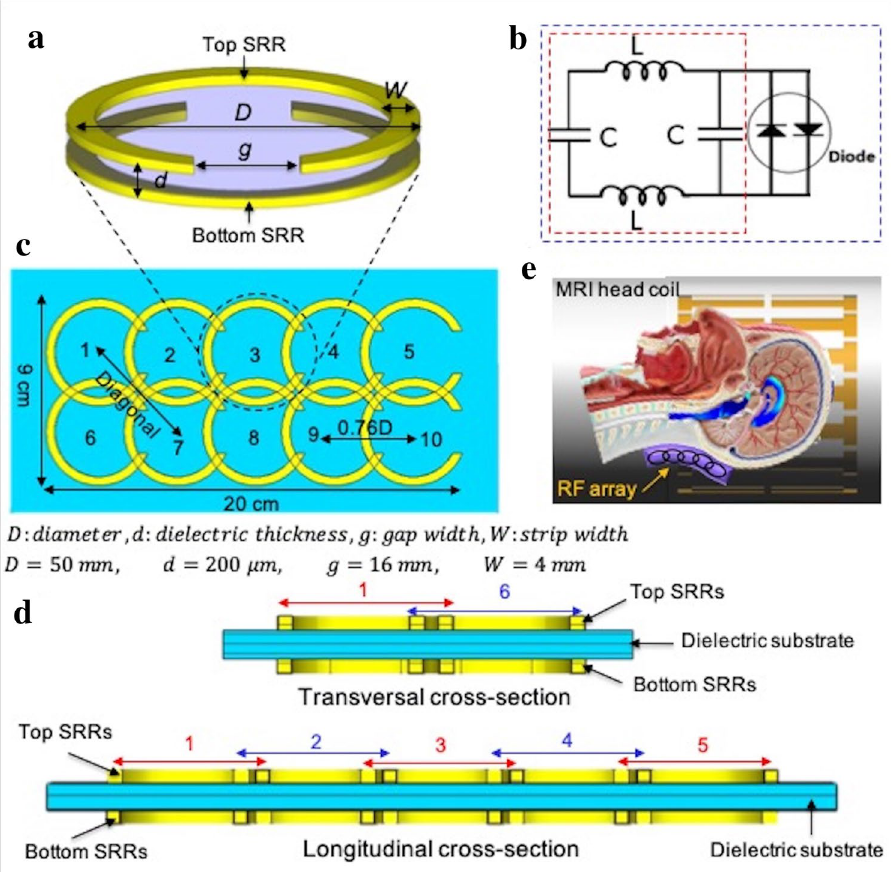
Figure 2. The modeling of the RF array. ( a ) 3D schematic of a passive resonator (BCSRR), which consists of two counter-oriented SRRs. BCSRR design parameters also are shown in 3D model, D is the diameter, W is the strip width, d is the dielectric thickness, and g is the gap width. In our design, we chose D = 50 mm , d = 200 μm, g = 16 mm, and W = 3 mm. ( b ) Electrical circuit model of the tuned BCSRR (encircled with red dashed). C is the built-in distributed capacitance and L is the inductance. The resistance (R) is not shown in this model. ( c ) A schematic of a 10-element RF resonator array consisting of 10 resonators in a 2 × 5 matrix. An anti-parallel cross diode is used to detune the strongly coupled elements from RF excitation to avoid RF over-flipping (diode is not shown in the 3D model). The corresponding circuit model is encircled with blue dashed in ( c ). ( d ) Cross-sectional view of the array in both transverse and longitudinal axis. The array consists of three layers; two top and bottom metal layers and a dielectric layer sandwiched in between. A thin layer of an insulator is implemented to avoid the physical contact between the overlapping elements (not shown here). ( e ) Schematic of the MRI head coil, wireless RF array, and human model. The array is positioned at the base of the skull such that extends outside from the coil to extend the spatial